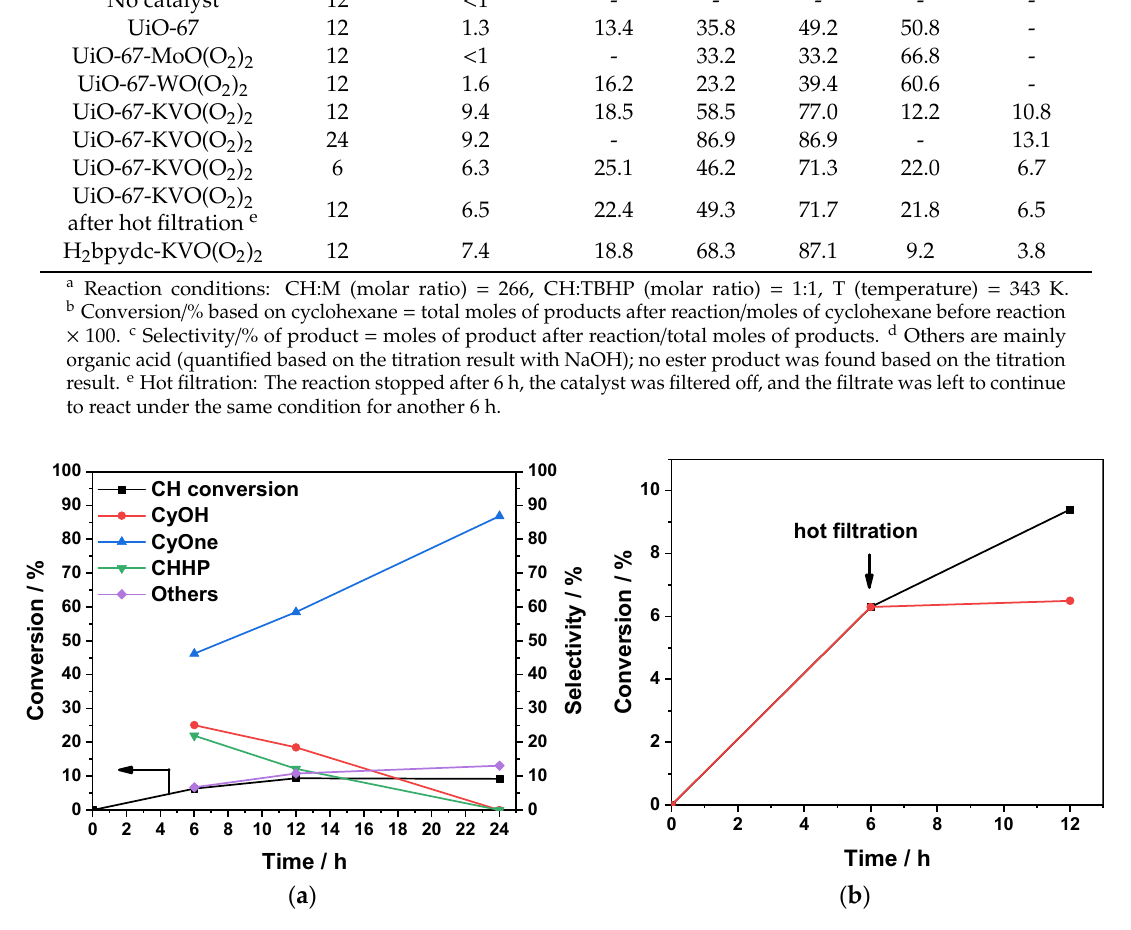
Table 2. The result of cyclohexane oxidation catalyzed by metal peroxide modified UiO-67 a .